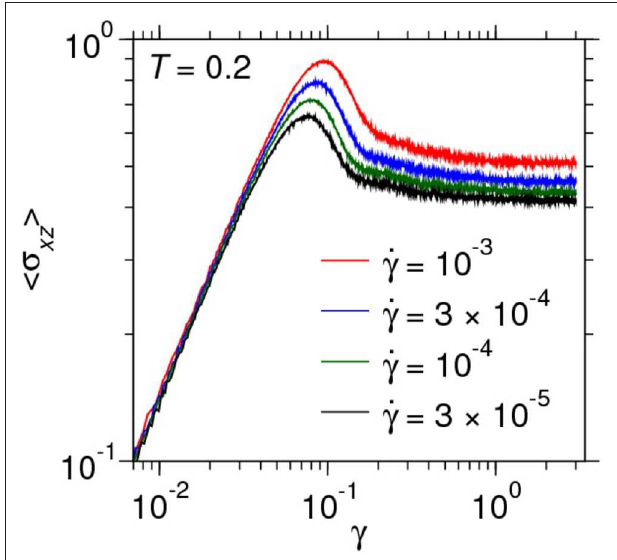
FIGURE 1 | Stress-strain relations, as obtained from the simulation, for different shear rates at the temperature T the shear is switched on, are glasses. Note that the shear rates are given in units of 1 /τ LJ